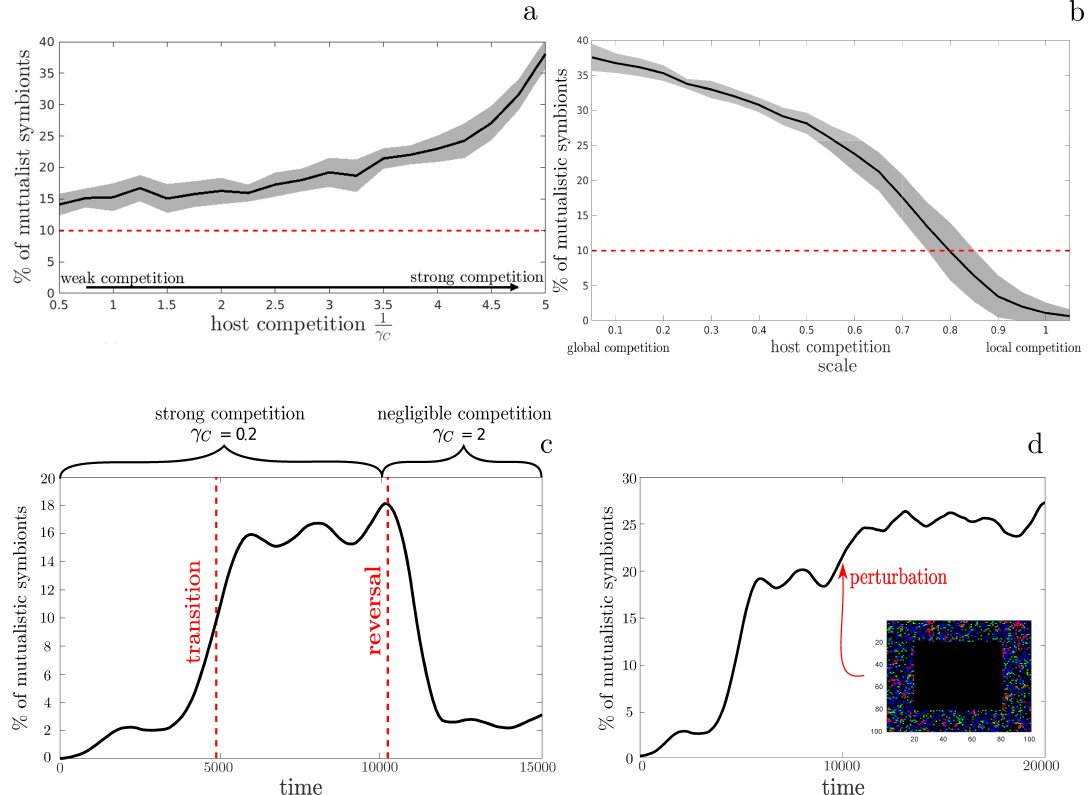
Figure 5. The role of host competition in the transition to mutualism. Effects of competition strength γ c (panel a) and spatial scale w h (panel b) on the percentage of mutualistic symbionts with dispersal cost d = 0 . 45 4 and after 10 time steps and over 50 replicates. Black curves is the median and shaded regions are 95% confidence intervals. Dashed red line is the transition threshold of 10%. In panel a) competition is global ( w h = 1 ) and in panel b) competition is strong γ C = 0 . 2 . Panel c) represents the effect of competition on the transition and on the maintenance of mutualism (simulation without dispersal cost d = 0 ). Panel d) presents the effect of a reduction in competition caused by a perturbation eradicating all organisms in a large square. 4 The perturbation occurs around t = 10 , which is 5000 time steps after the transition. Other parameters are m = 0 . 06 , c m = 0 . 3 , f h = 0 . 1 , f s = 2 . 5 , f max = 8 , f a = 0 . 5 and β max = 0 . 5 min min